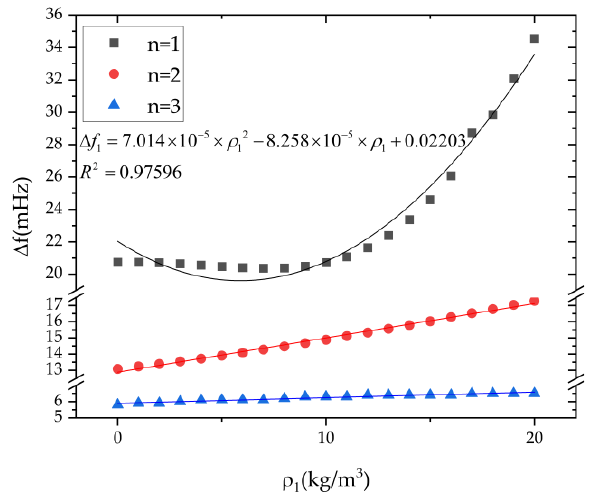
Figure 6. The influence of the first harmonic ρ 1 on the frequency split of n = 1, 2, 3 modes. The influence of the second harmonic error on the frequency split is shown in Figure 7. With the increase in the second harmonic error, the frequency split of the n = 1 mode increases rapidly, and the frequency splits in the n = 2 and n = 3 modes are only slightly changed. The frequency split of the n = 1 mode is approximately linear with the second harmonic error. The frequency split of the n = 1 mode is 12.45 mHz when the second harmonic error is 20 kg/m 3 . From the fitting results, the frequency split of the n = 1 mode is proportional to the second harmonic, which is consistent with the theoretical formula. In addition, although the first harmonic can also cause an increase in the n = 1 frequency split, its contribution is far less than the second harmonic. It is still in line with the theoretical model.